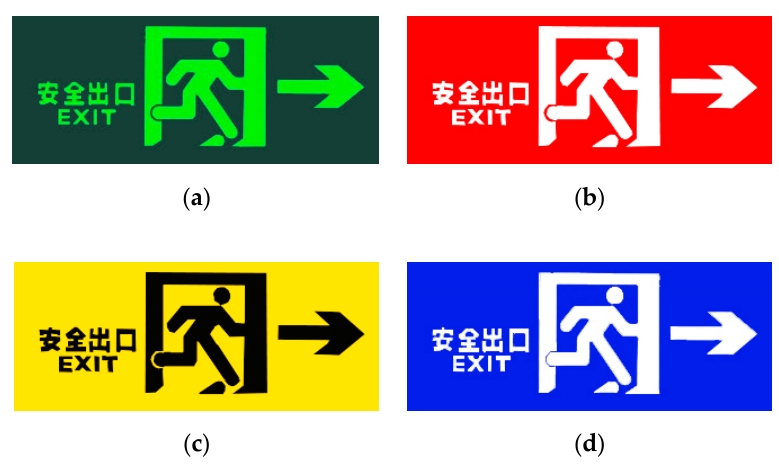
Figure 4. Four different colors of safety signs. ( a ) “Green and black”; ( b ) “Red and white”; ( c ) “Yellow and black”; ( d ) “Blue and white”. The size of the above safety sign pictures is 359 × 149 × 23 mm in the virtual scene, the same picture size as in the real Zijing Mountain subway station (1:1 scale). Table 1. The standards referenced in this paper.